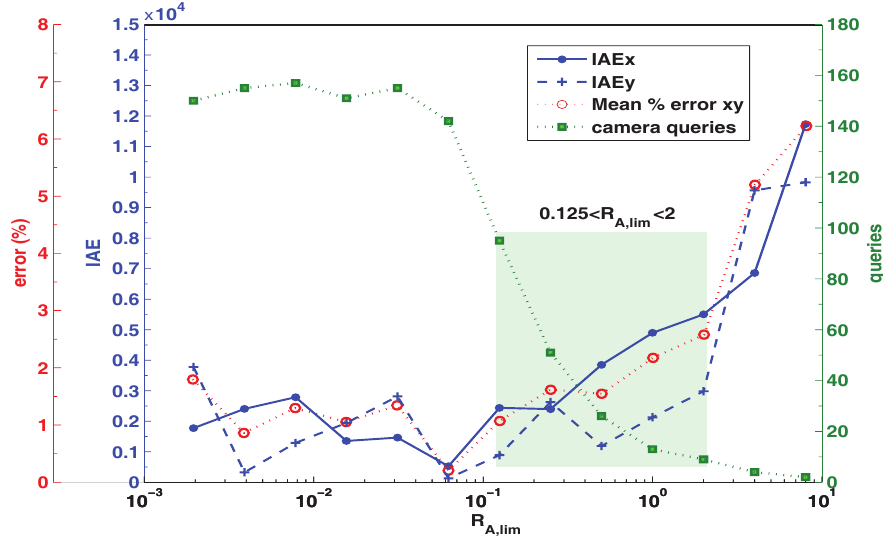
Figure 7. Relation between R , IAE performance, mean percentage error and camera A;lim queries for a 3 min square trajectory test, differential